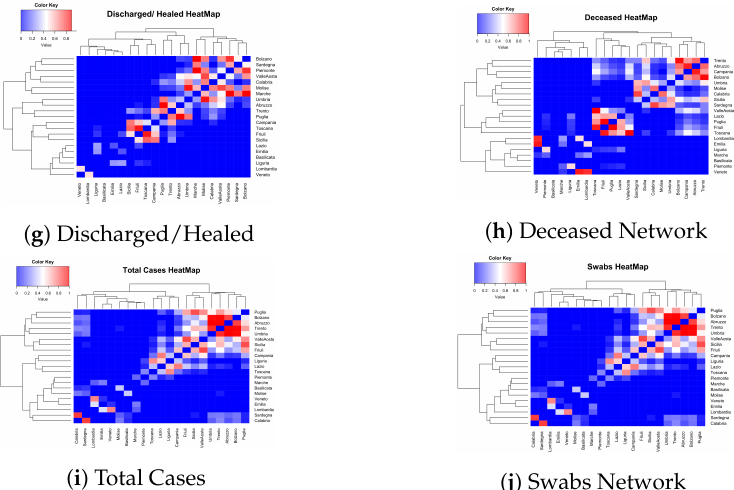
Figure A1. The figure shows the heat map related to results obtained by applying Wilcoxon Sum Rank test in the study period on Italian COVID-19